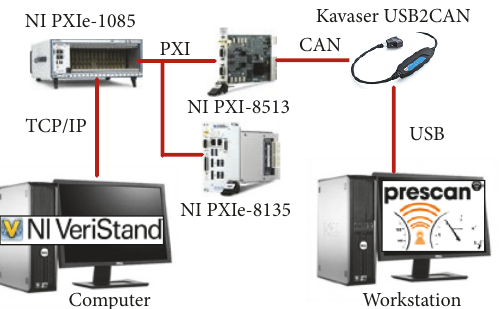
Figure 4: Bench test system for validation of the platoon control system.